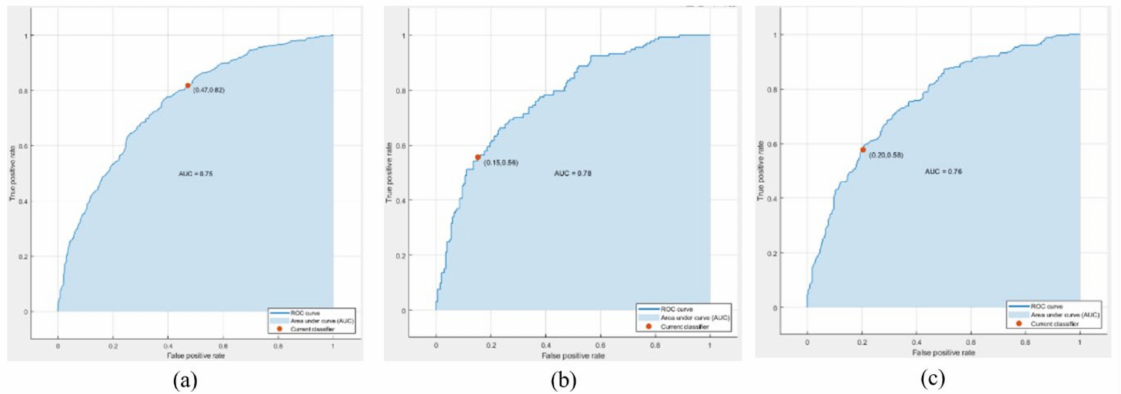
Figure 13. ROC curves and AUC values showing best outcomes of ( a ) mixed views with MGVM, ( b ) back views with CSVM, and ( c ) front views with QSVM of IPeR dataset utilizing 1000-feature